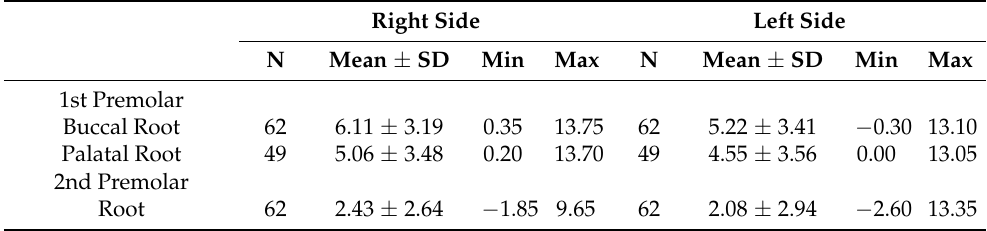
Table 1. Mean root–maxillary sinus distances in mm for premolars. Right Side Left Side